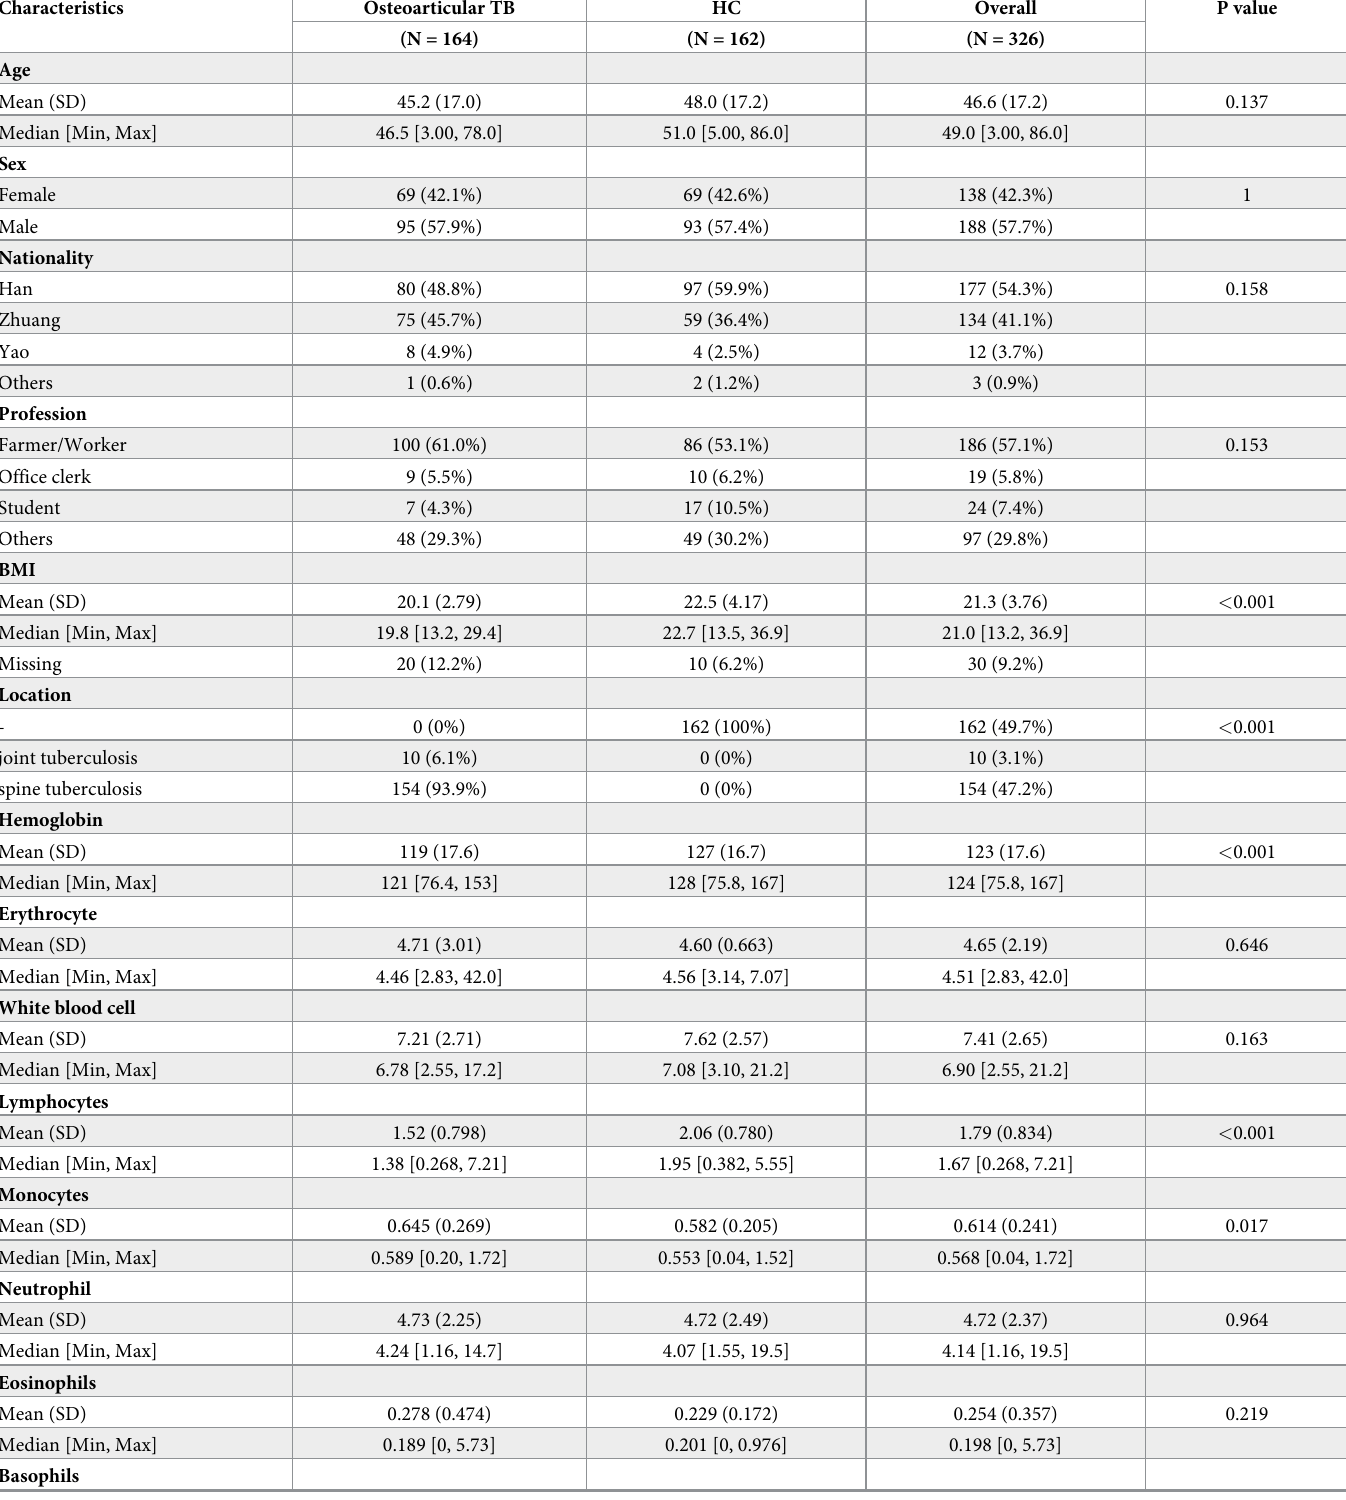
Table 1. Baseline characteristics of